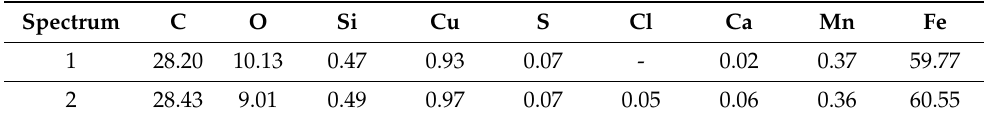
Figure 4. ( a ) SEM images of the corrosion scales of L245N standard steel and ( b ) the enlarged im- age of the selected area marked in ( a ) after 1/2 day of testing.